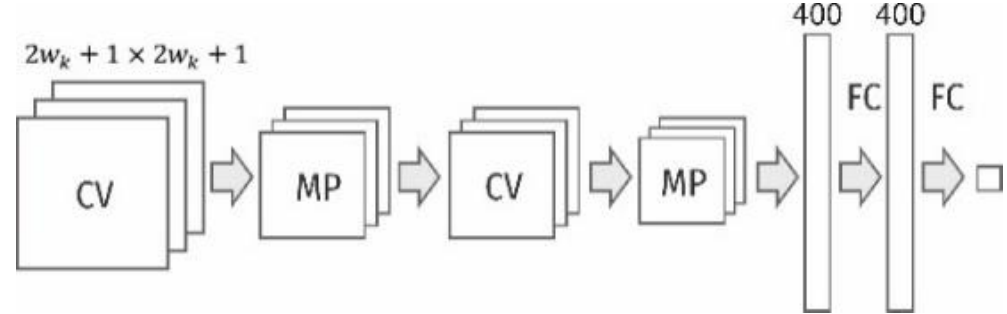
Figure 1. Architecture of the neural network used for the investigation of fractograms.